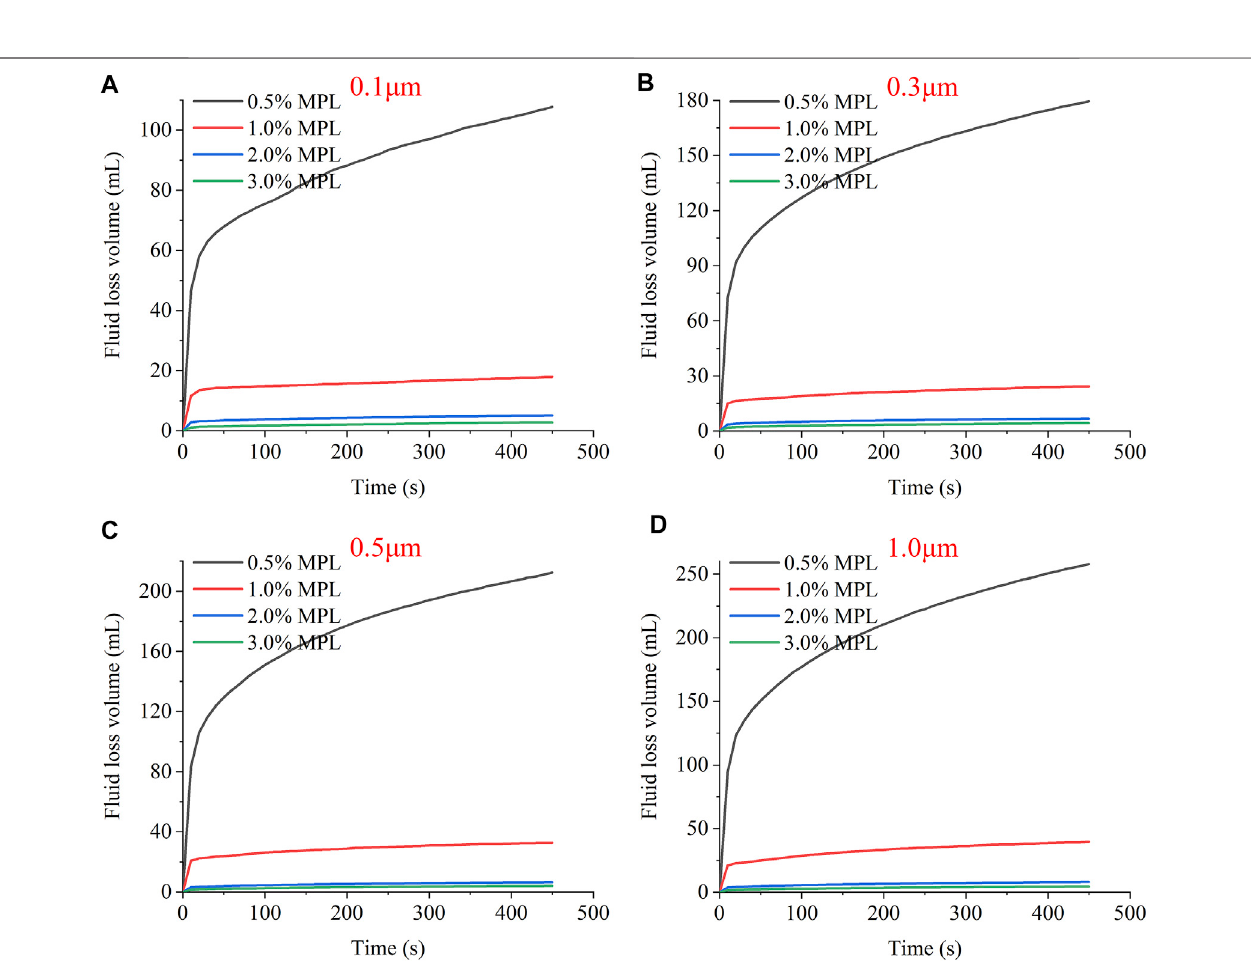
Frontiers in Chemistry |